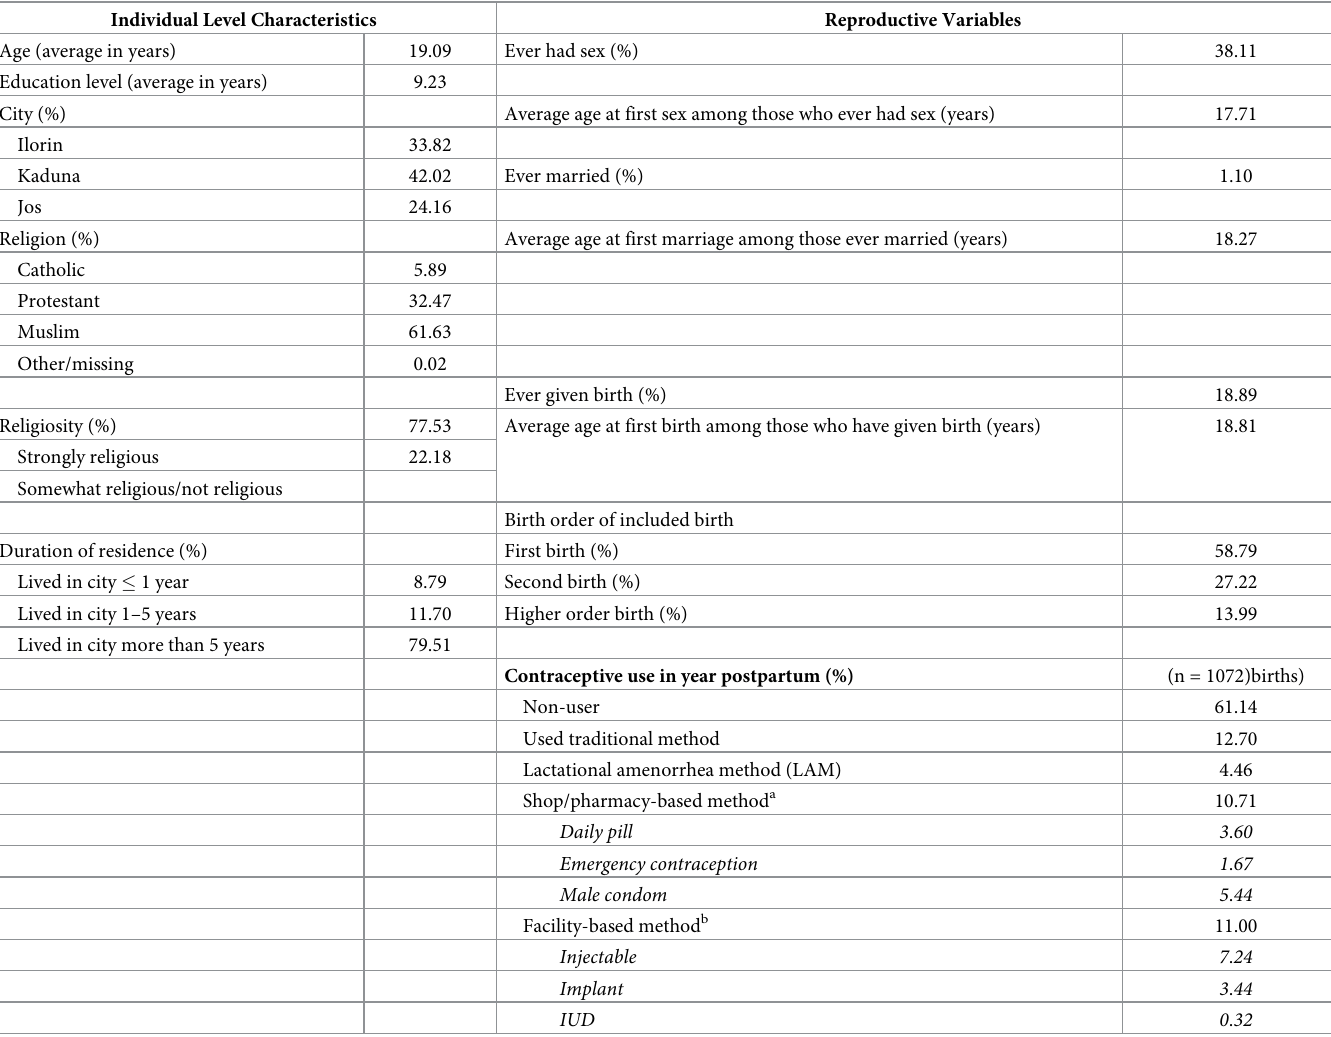
Table 1. Descriptive characteristics of the sample of women ages 15–24 at the time of the survey, Ilorin, Kaduna, and Jos, Nigeria, 2017. Individual Level